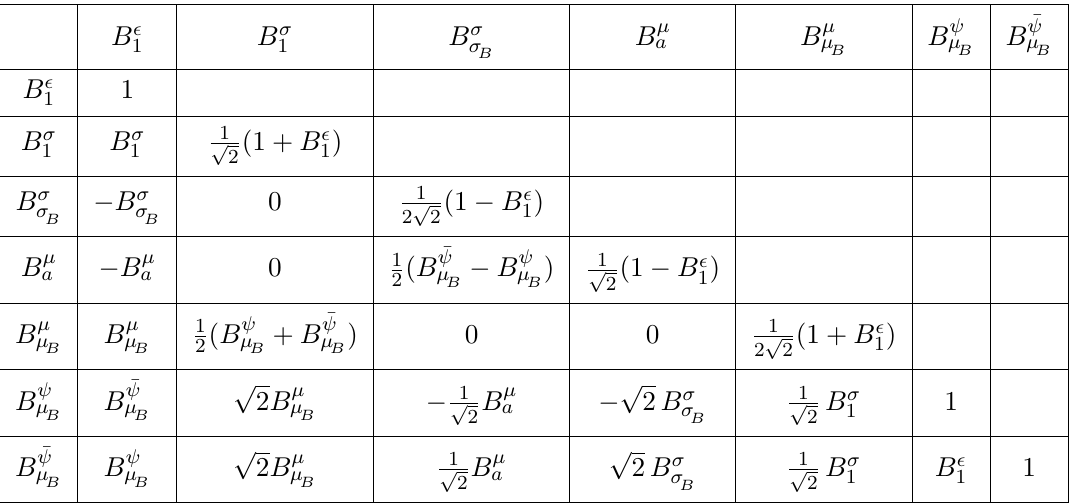
B (cid:12) = P C (cid:11)a;(cid:12)b(cid:13)c B (cid:13) and a c (cid:13);c b